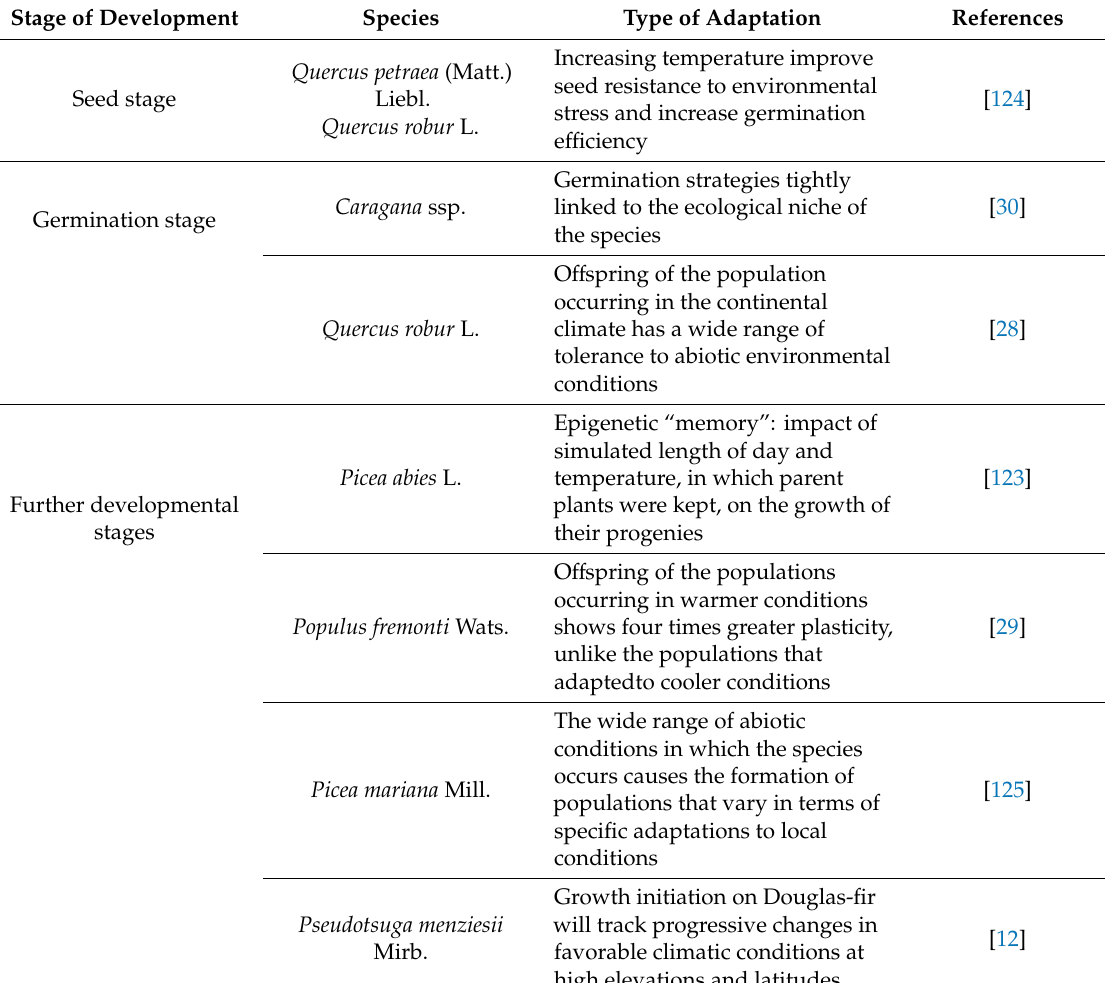
Table 1. Diversifying the forms of adaptation of selected tree species to changing climatic